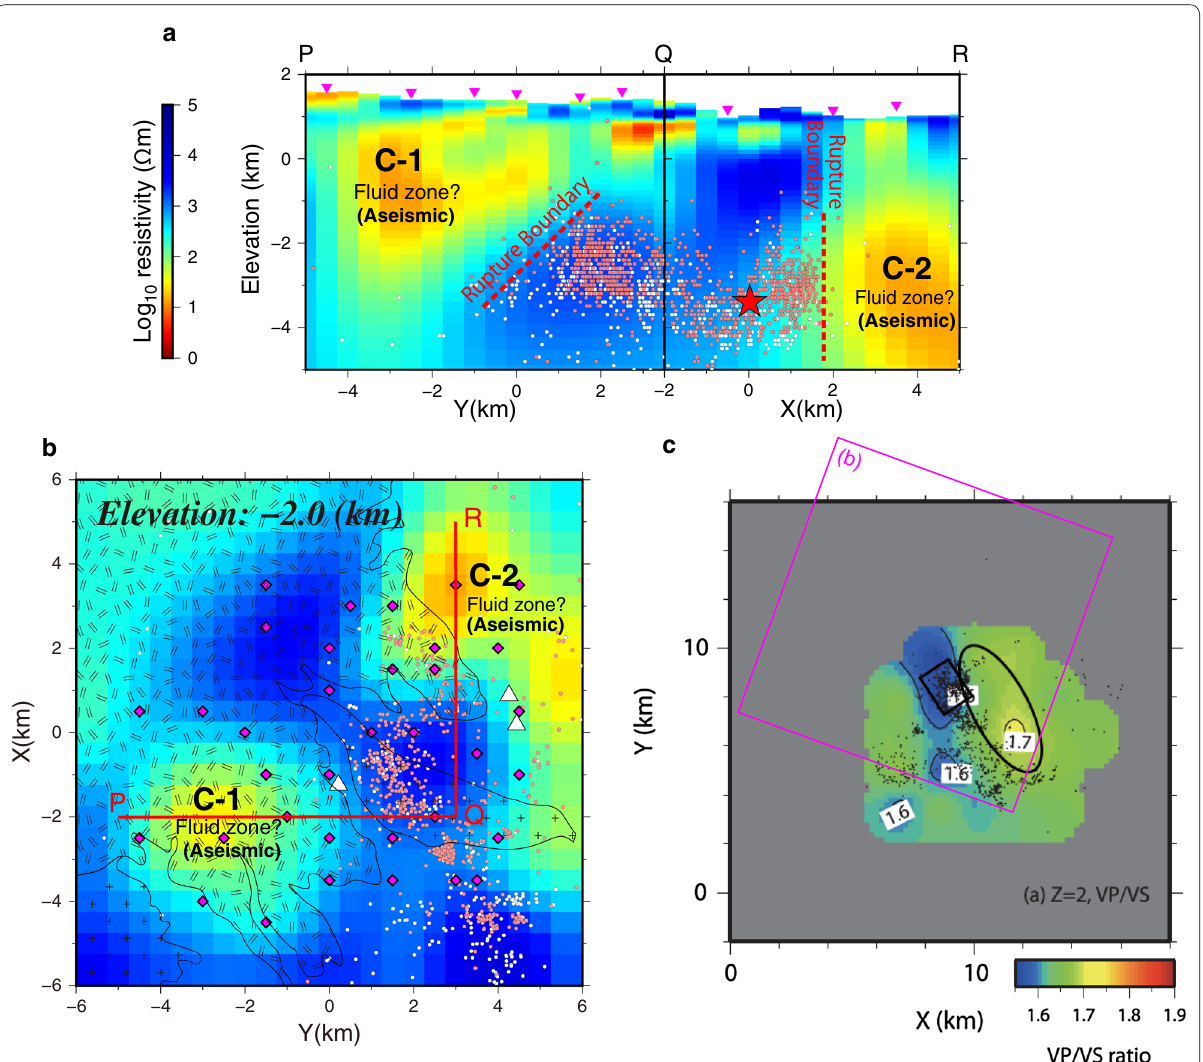
Fig. 5 a Vertical cross section of the 3D resistivity inversion model with interpretations along the lines P-Q and Q-R shown in Fig. 4a and 5b. Inverted triangles denote MT site locations. Other symbols are the same as in Fig. 4. b Horizontal cross section of the inverted 3D resistivity model (elevation 2 km) with surface geological map. Symbols are the same as in Fig. 4. c Horizontal cross section of the Vp/Vs model by Doi et al. (2013) − (elevation 2 km). The purple rectangle shows an approximate range of ( b −